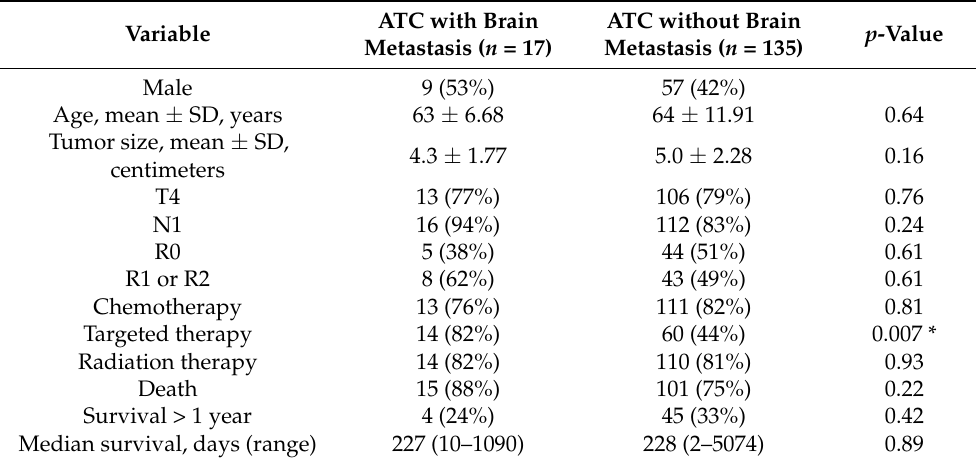
Table 3. Clinical features of patients with ATC with brain metastasis.